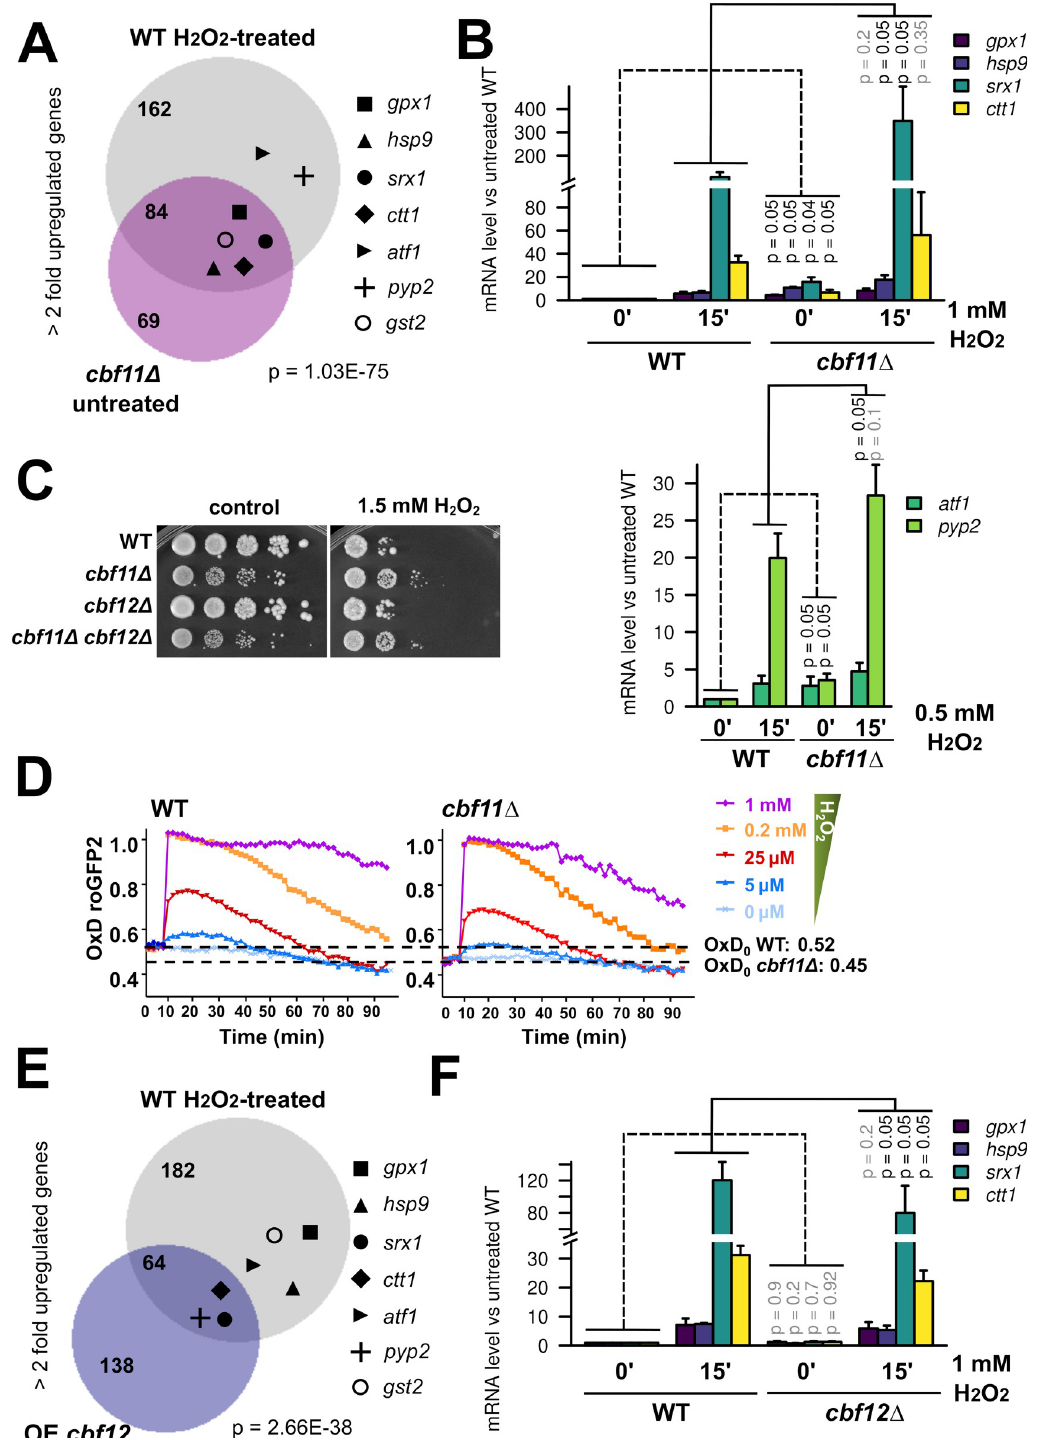
Fig 1. Absence of Cbf11 leads to activation of stress-response genes. (A) Venn diagram of genes upregulated more than 2-fold in WT cells after 15 min treatment with 1 mM H 2 O 2 in EMM medium (data from [34]), and genes upregulated more than 2-fold in cbf11 Δ cells growing exponentially in YES medium (data from [15]). The group membership of stress genes from panel B is indicated with symbols. Overlap significance was determined by two-sided Fisher’s exact test. (B) Expression of the indicated stress genes in WT and cbf11 Δ cells treated or not with the indicated concentrations of H 2 O 2 for 15 min in YES was analyzed by